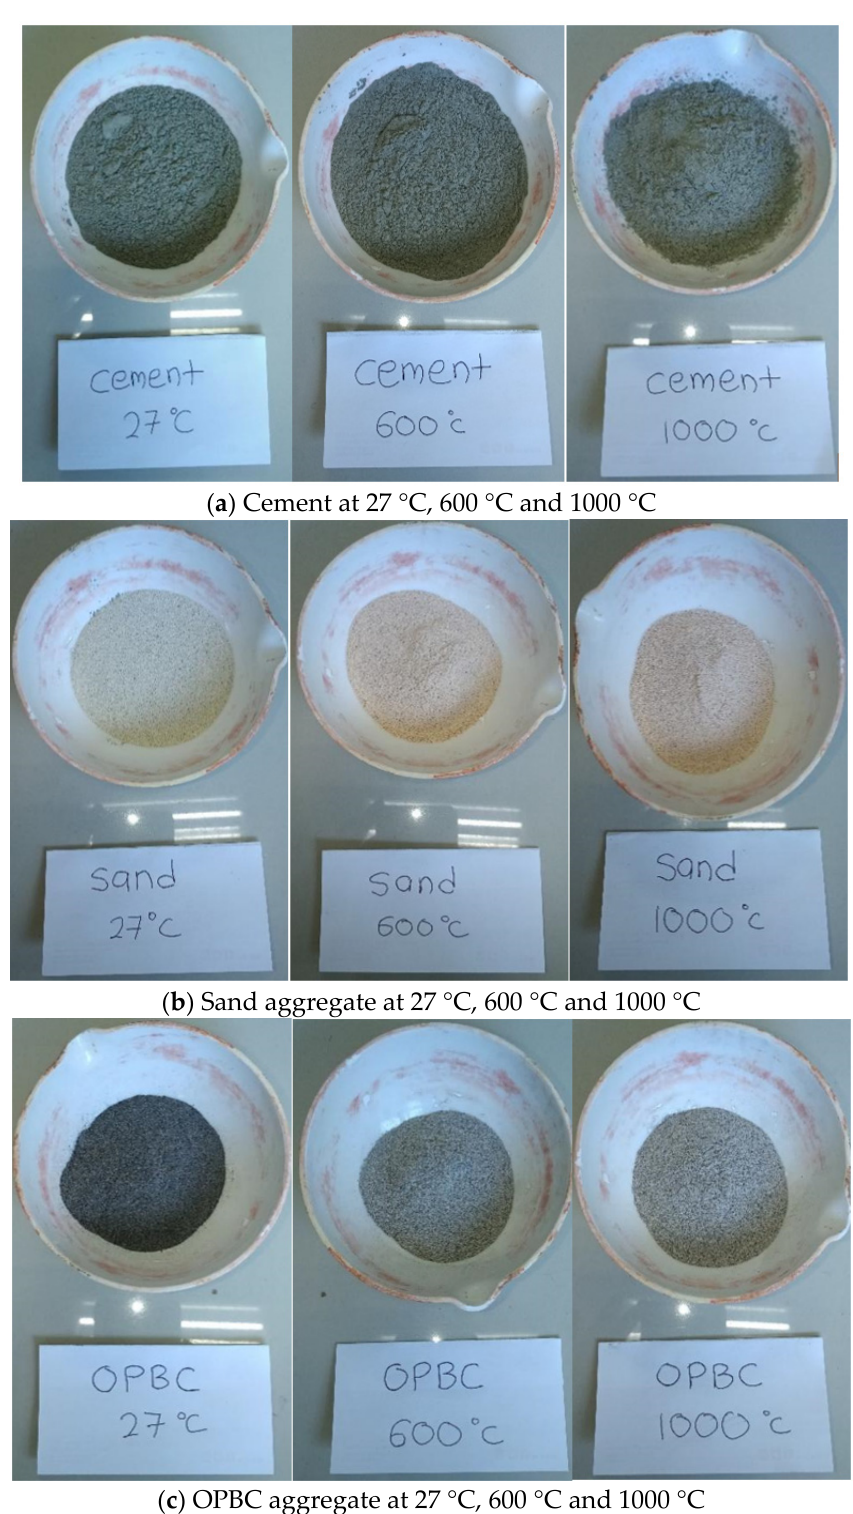
Figure 4. Colour changes at different temperatures: ( a ) cement; ( b ) sand aggregate; ( c ) OPBC aggre- gate.